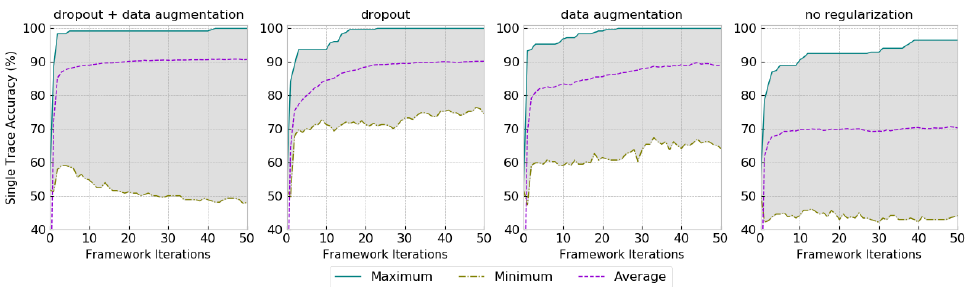
Figure 10: Random CNN hyperparameters: minimum, maximum, and average single trace accuracy with iterative framework on the cswap-pointer dataset for random CNN